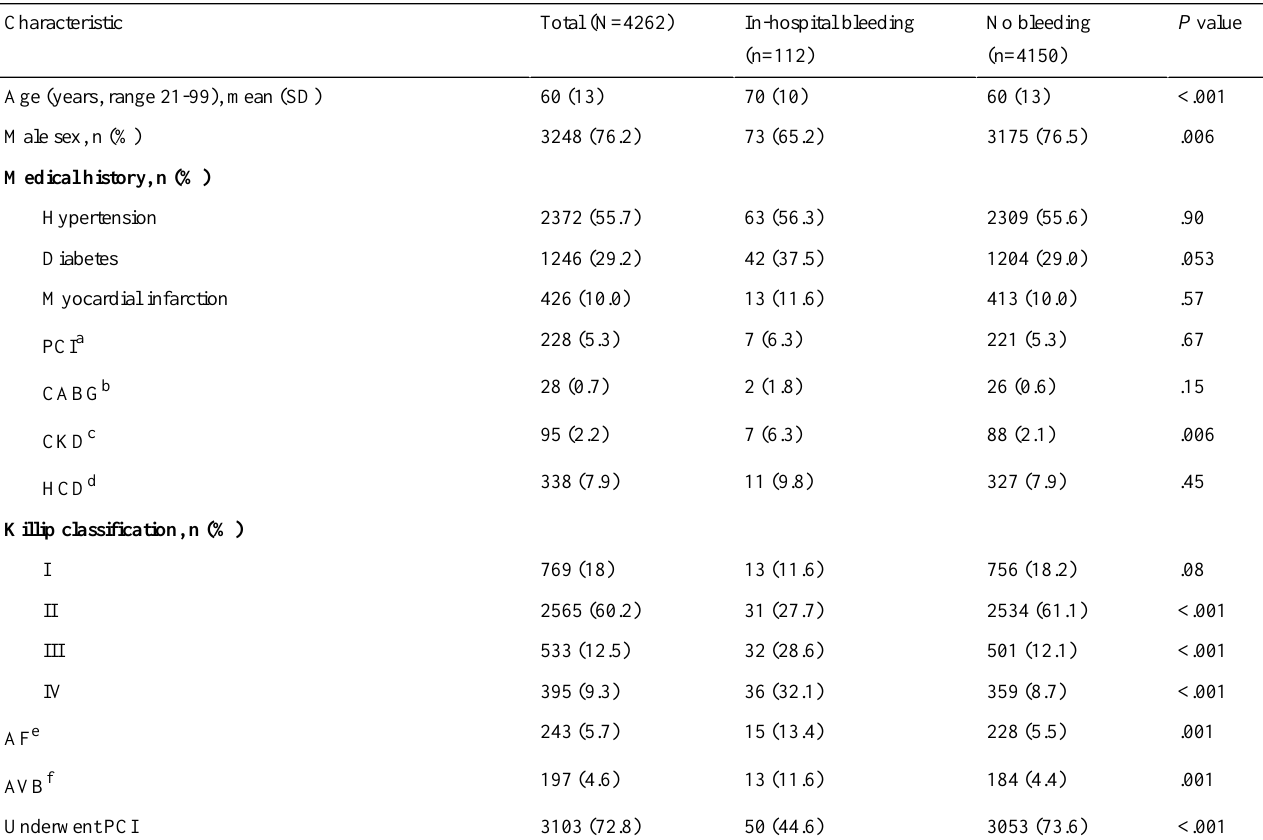
Table 1. Demographic and clinical characteristics of patients with and without in-hospital bleeding in the development data set (N=4262).